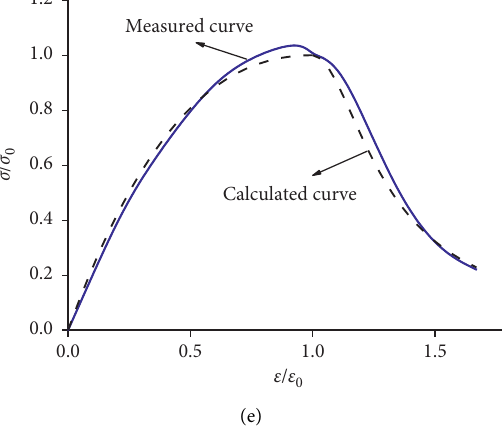
Figure 13: Comparison of the measured and calculated stress-strain curves. (a) c � 0%. (b) c � 25%. (c) c � 50%. (d) c � 75%. (e) c �